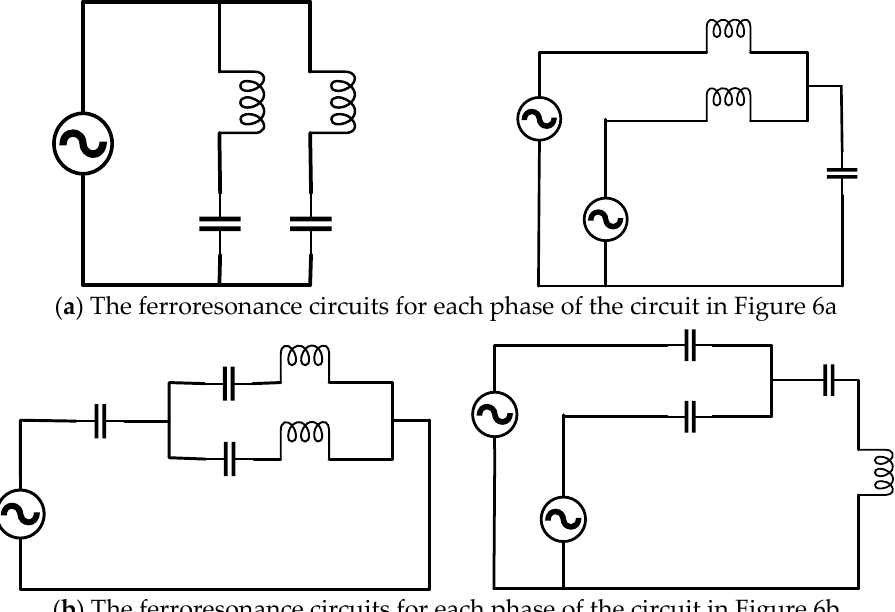
Figure 7. The ferroresonance circuits for each phase of the circuits in Figure 6.